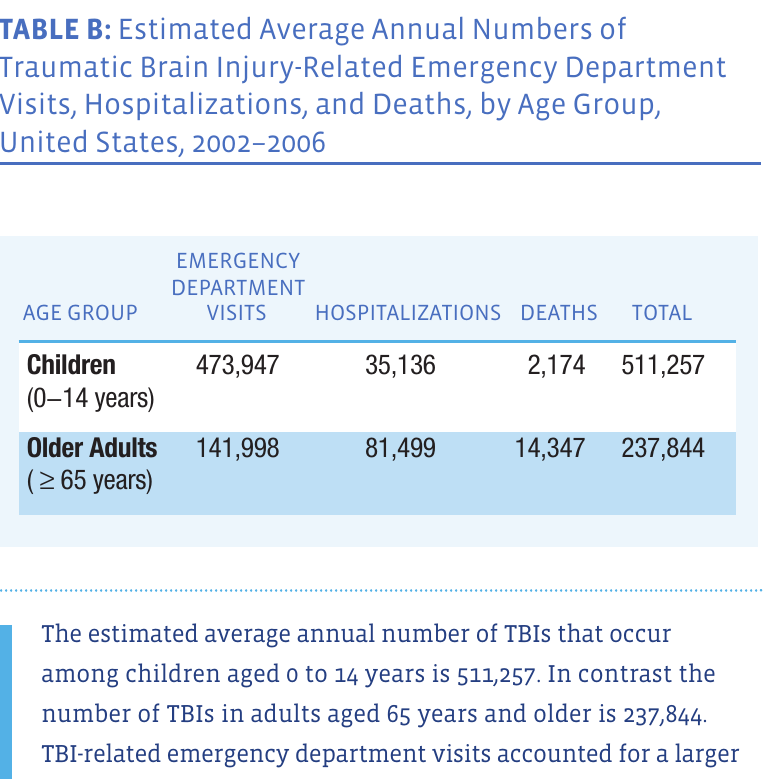
overview | tBI by Age group